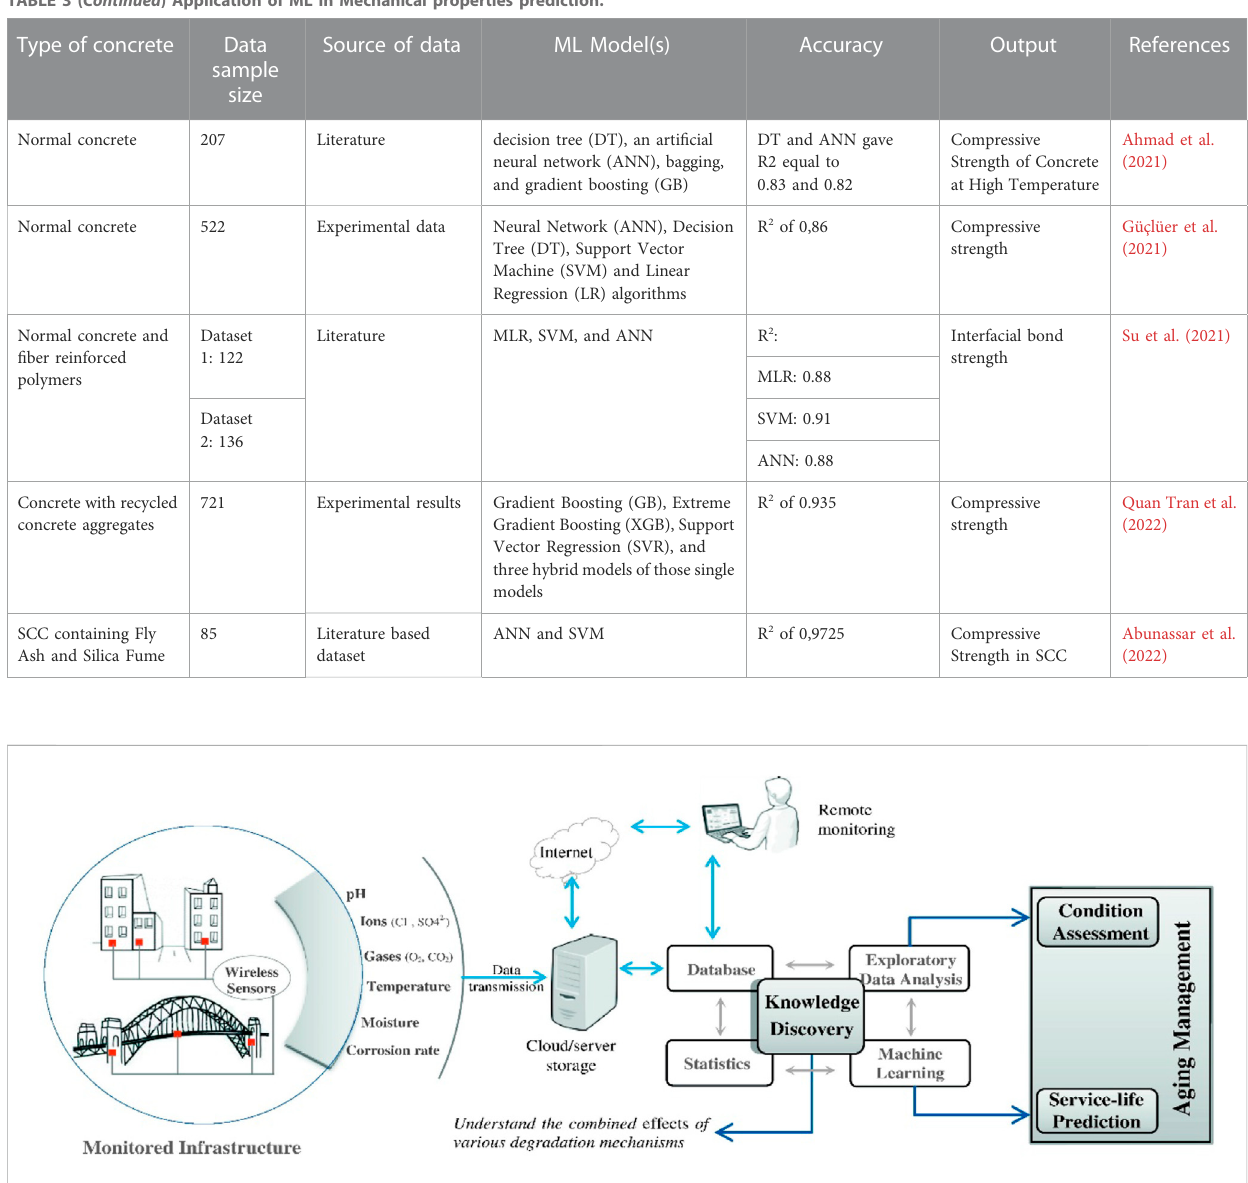
FIGURE 6 Assessment of durability and service life of reinforced structure (Taffese and Sistonen, 2017).